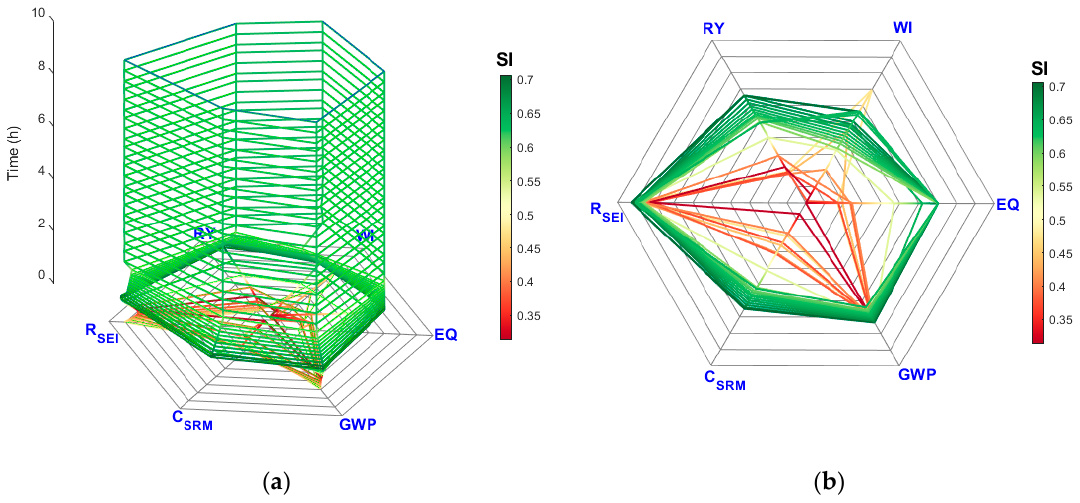
Figure 12. Case 2—dynamic sustainability performance without sustainability constraint: ( a ) 3D sustainability indicator dynamic radar plot; ( b ) 2D projection of sustainability indicator radar plot.